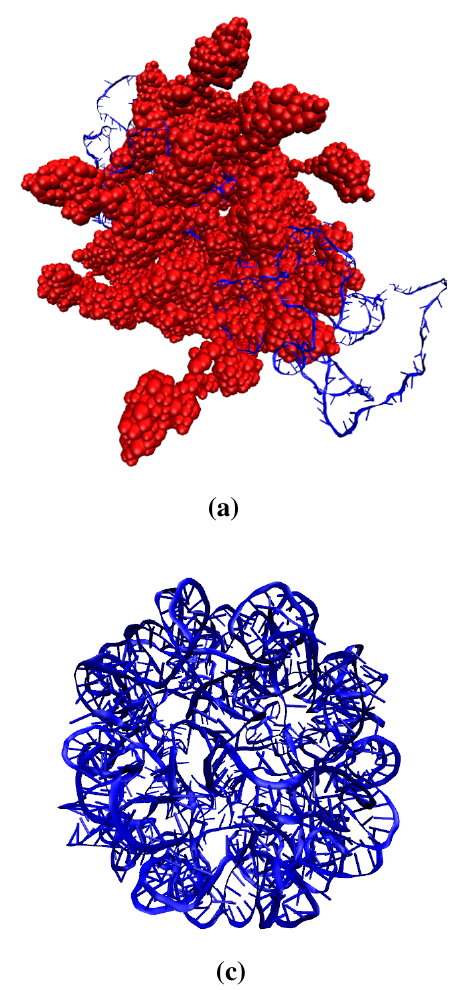
Figure 1. ( a ) Initial (0 ns) and ( b ) final (10 ns) structures of the STMV protein monomers aggregating with RNA; ( c , d ) same as (a) and (b), respectively, but for the expansion of free RNA in aqueous solution. These simulations are chosen to illustrate two contrasting scenarios of inter-subsystem interaction and their effect on the Langevin dynamics of the order parameters (OPs). The random coil structure of the RNA in (a) is generated using the ROSETTA molecular modeling software package, and the icosahedral symmetric form is extracted from its encapsidated state, as also used in